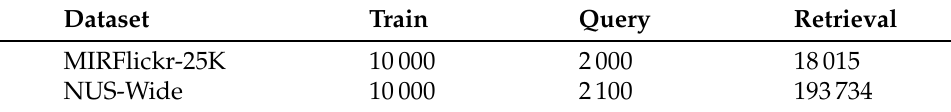
Table 1. MIRFlickr-25K and NUS-Wide dataset characteristics.